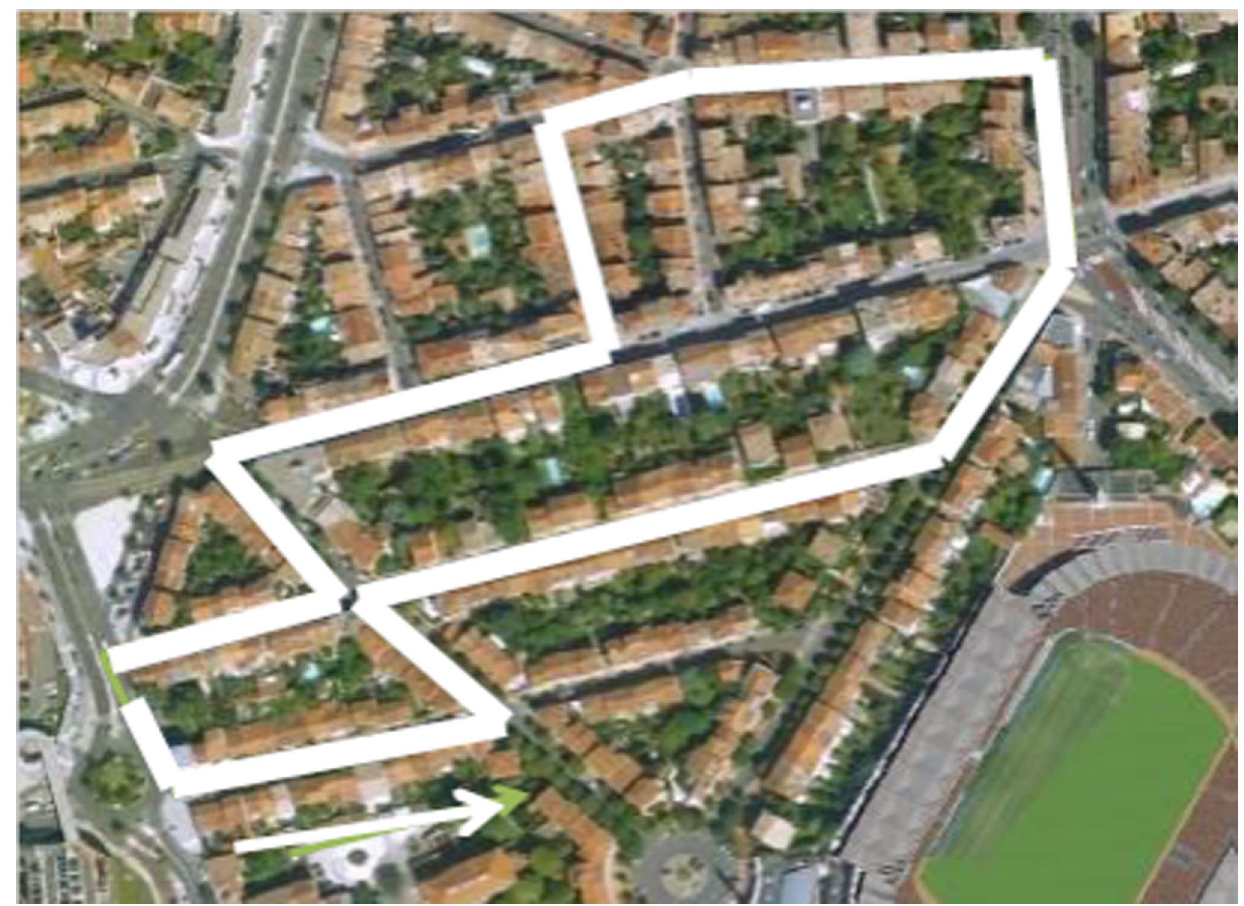
Figure 1. Representation of the district area and of the route used for the experiment. doi:10.1371/journal.pone.0067193.g001 PLOS ONE |